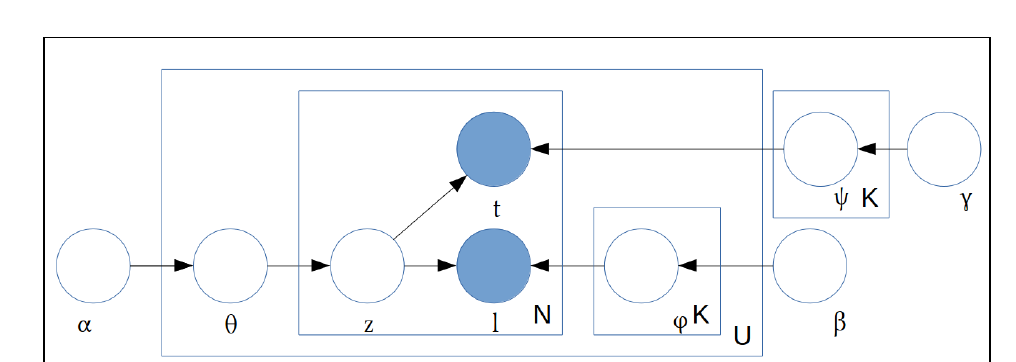
Figure 2. Graph model of our extended LDA model. Shaded and unshaded nodes denote observed and latent variables, respectively.